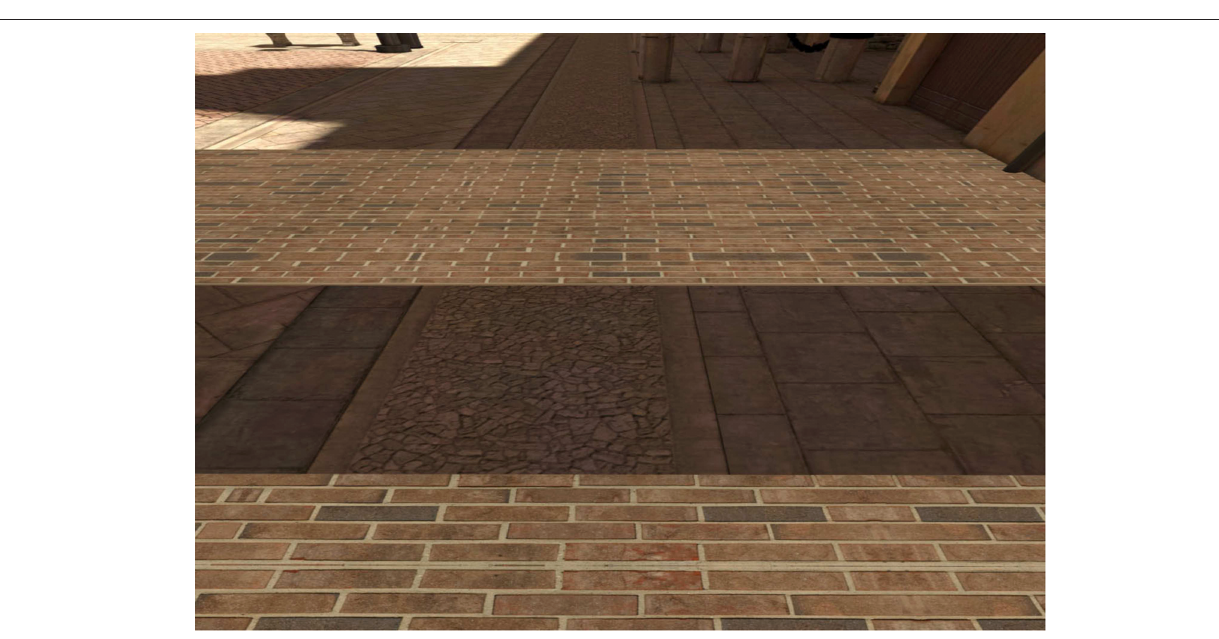
varied by increments of 0.1 m (i.e., 0.55, 0.65, and 0.75 m,